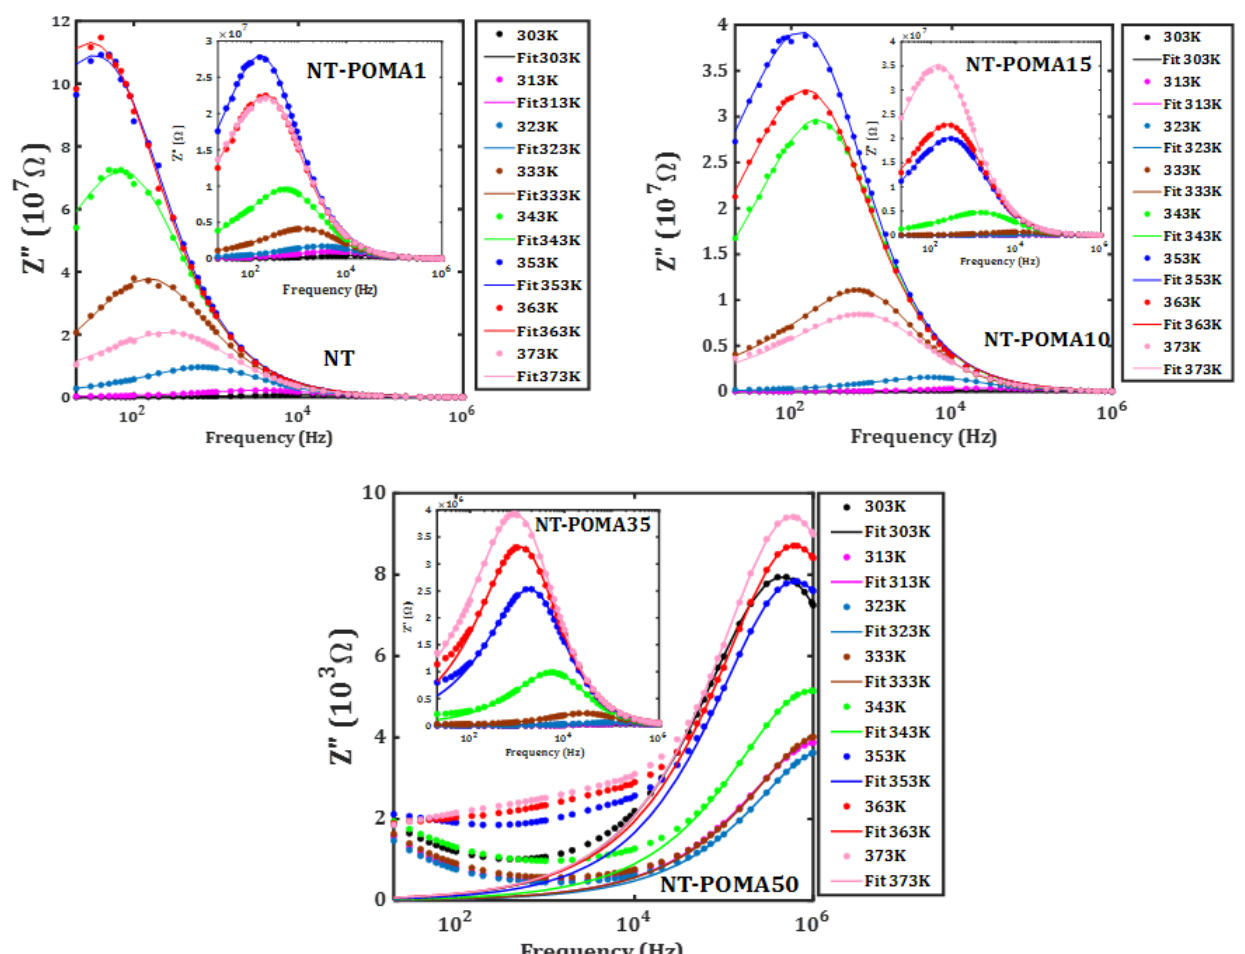
Figure 5. Frequency dependence of the imaginary component of the impedance from 303 K to 373 K. The samples NT, NT-POMA1, NT-POMA10, NT-POMA15, NT-POMA35 and NT-POMA50 correspond to 0.0%, 0.1%, 10%, 15%, 35% and 50% of POMA content, respectively.